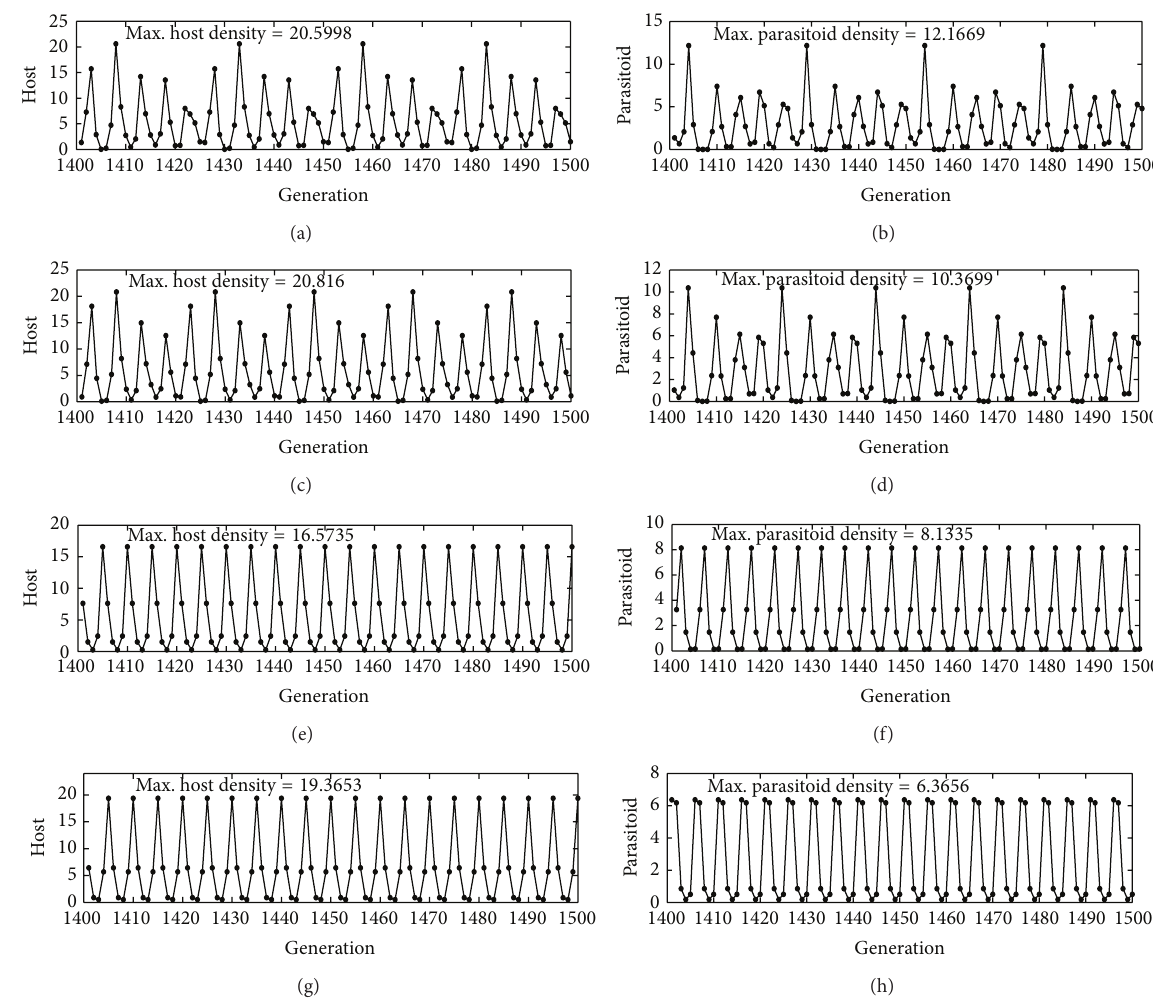
Figure 3: Four coexisting attractors of system (3) with parameters 𝑝 = 0.65 , ET = 7.5 , 𝛽 = 0.5 , 𝜏 = 2 , 𝛼 = 25 , 𝑏 = 1 . The initial conditions of ((a)-(b)), ((c)-(d)), ((e)-(f)), and ((g)-(h)) are (𝐻 0 , 𝑃 0 ) = (7.4,0.6), (6, 2),(6.2, 4.5) , and (6,4.8) , respectively. ((a)-(b)) Periodic attractor with period 25, ((c)-(d)) periodic attractor with period 20, ((e)-(f)) periodic attractor with period 5, and ((g)-(h)) periodic attractor with period